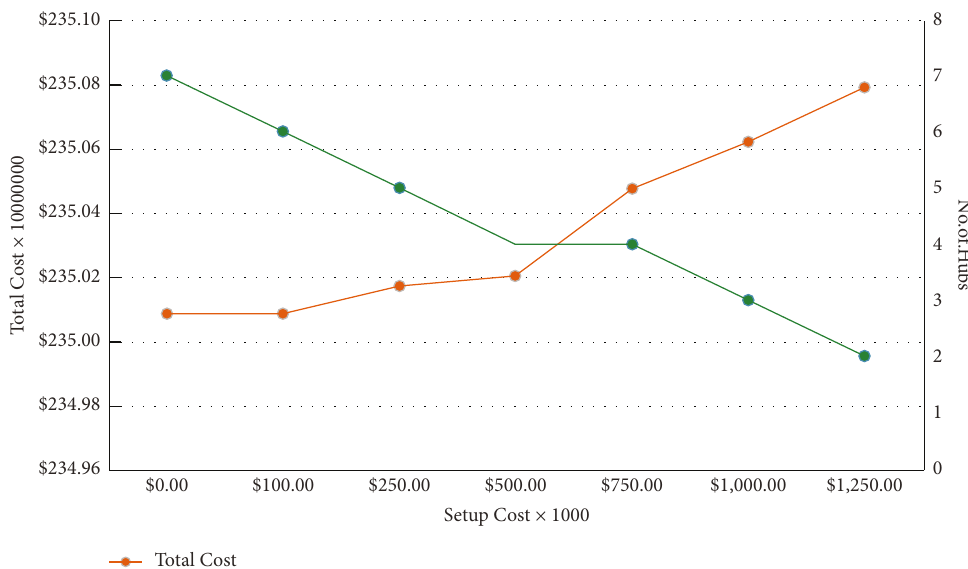
Figure 8: Impacts of set-up cost, total cost, and no. of